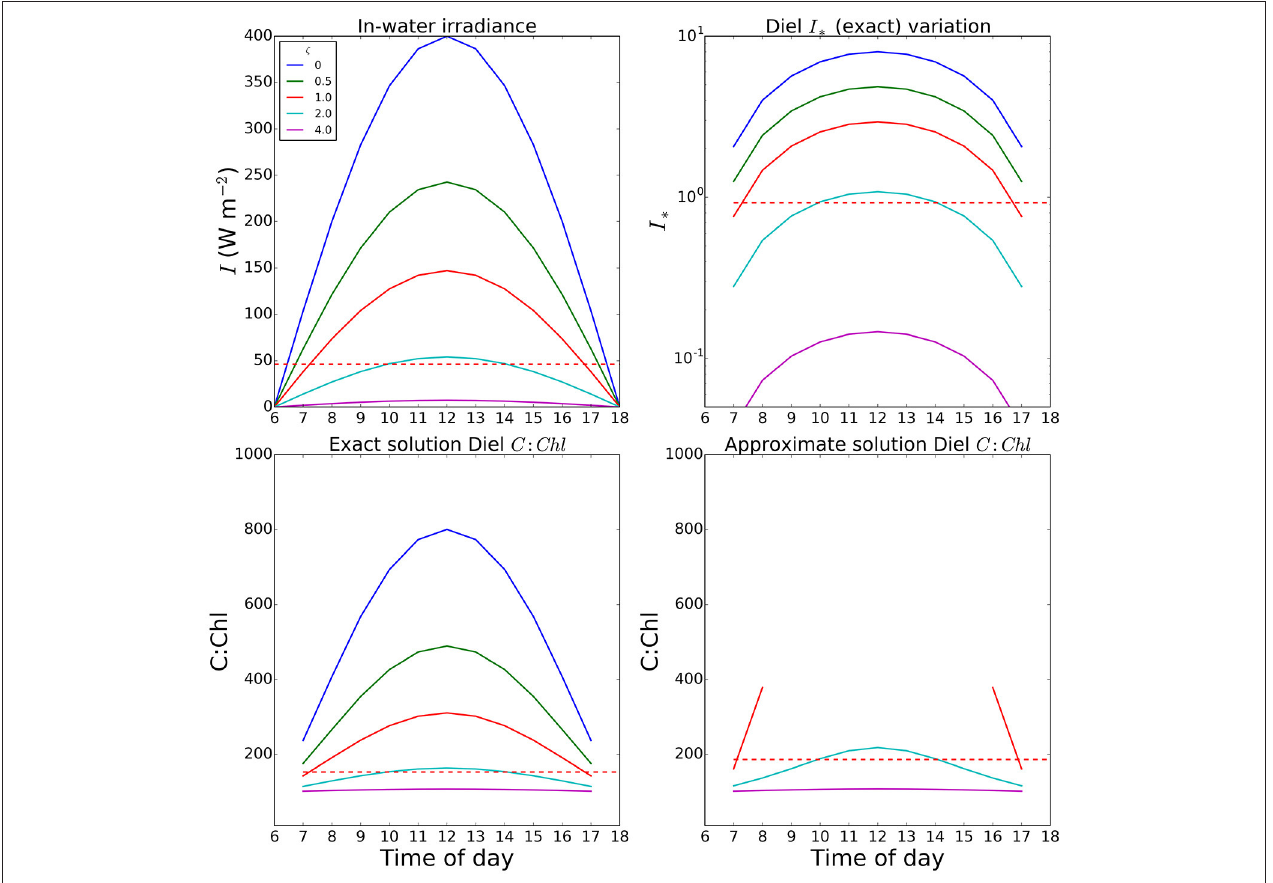
FIGURE 5 | Variation in I * and resultant C:Chl ratios through the a diurnal cycle at various optical depths in a simple optical model. The value set for I k (50.0 W m 2 ) was taken as a reasonable value from the fields seen in Figure 2 . Both I k and θ m (0.01) were assumed uniform within a mixed layer extending to the euphotic depth. Dashed red lines show the value for the first optical depth when calculations are performed using a daily mean (24-h time step). Missing values in the final panel are due to values of I * exceeding the limit of the Taylor expansion.